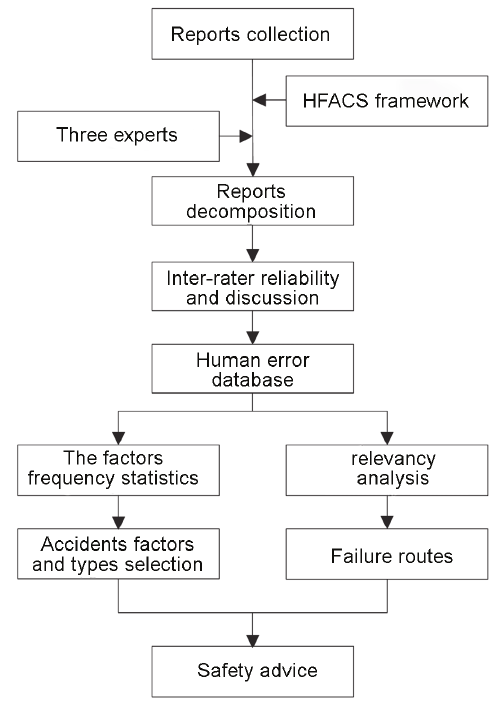
Figure 1. The flowchart of this some difference of specific description of each factor. In